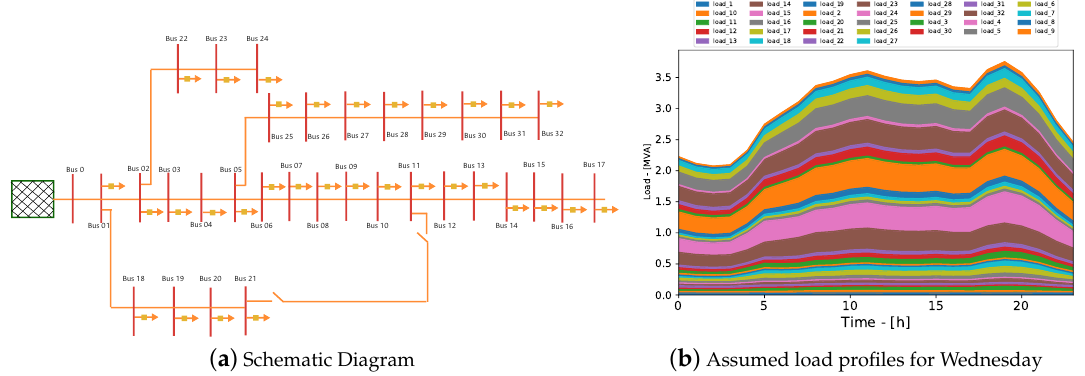
Figure 9. IEEE 33 bus radial distribution